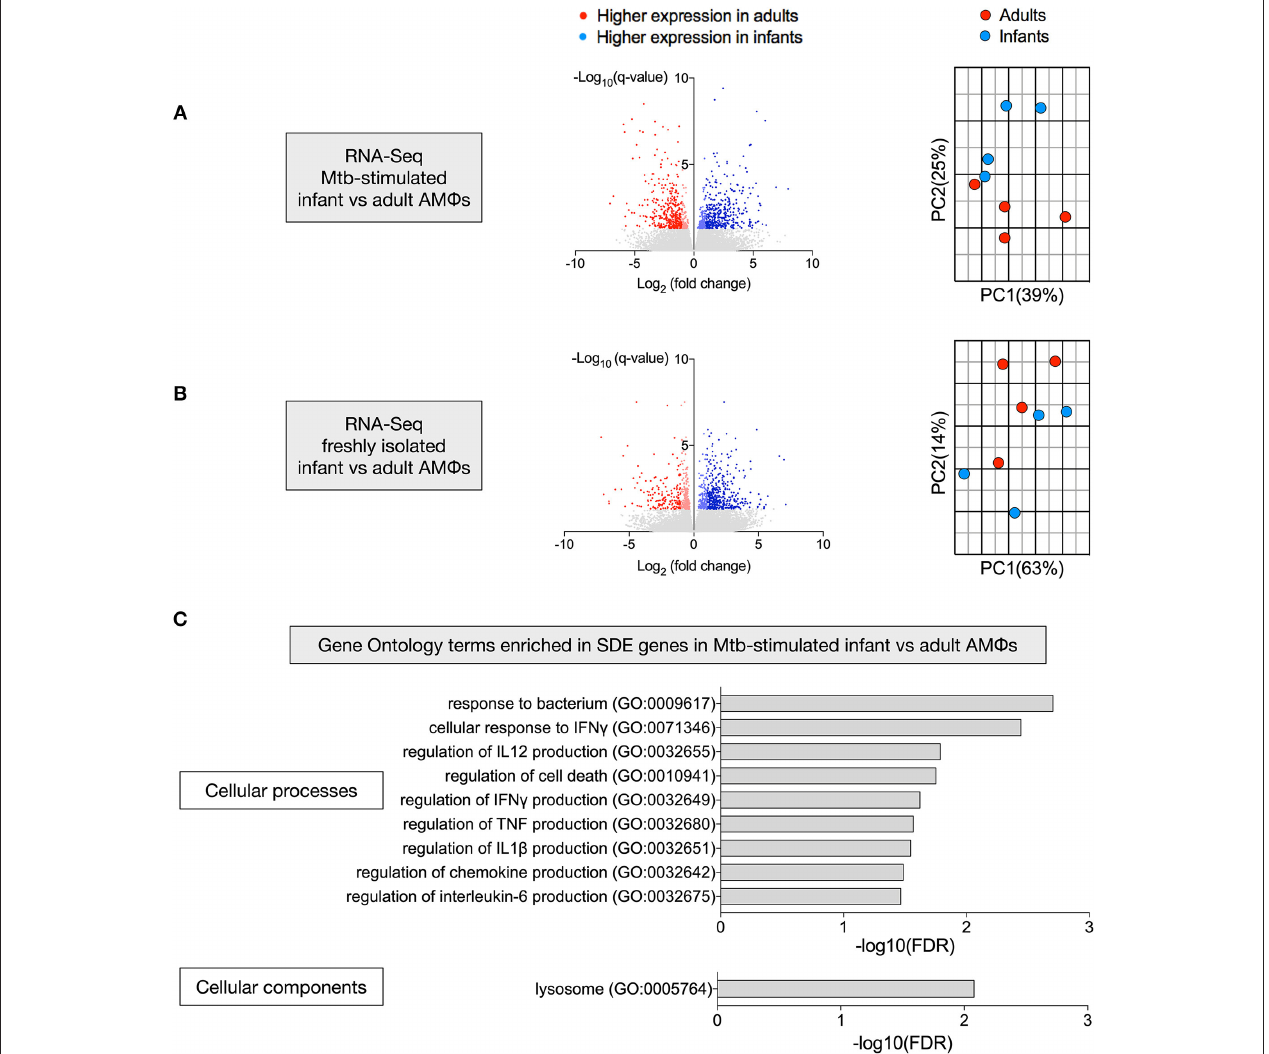
FIGURE 3 | Transcriptional disparity between Mtb-stimulated infant vs. adult AM φ s. RNA-Seq of infant vs. adult AM φ s following (A) infection with Mtb H37Rv at MOI 5:1 for 24h; and (B) adherence of freshly isolated cells for 1h. For volcano plots (left), blue dots represent genes that were significantly (FDR < 0.05) differentially expressed (SDE) more highly in infants [log2(fold change > 1 infant expression/adult expression)], and red dots represent genes that were SDE more highly in adults [log2(fold change < -1 infant expression/adult expression)]. For Principal Component Analyses (right), blue dots represent each individual infant participant and red dots represent each individual adult participant. (C) Gene ontology (GO) enrichment analysis of SDE genes in Mtb-stimulated infant vs. adult AM φ s showing significantly enriched GO terms for cellular processes (top) and cellular components (bottom).